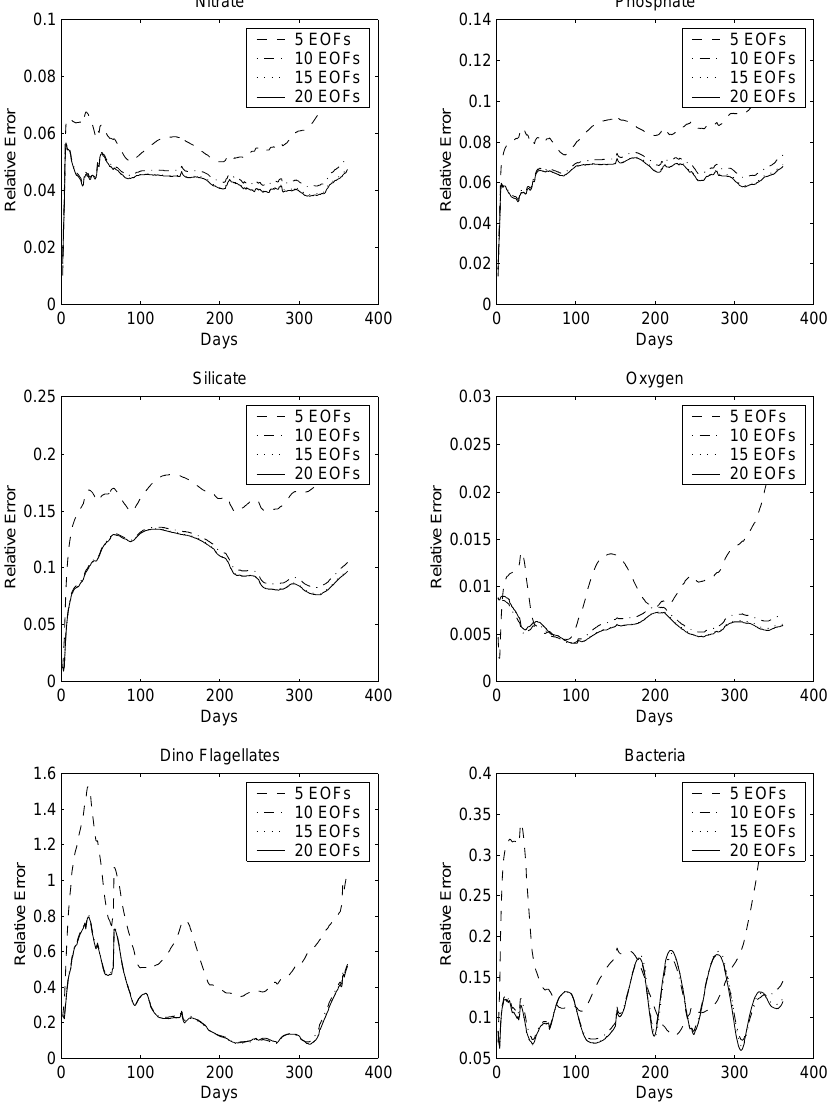
Fig. 4. Evolution in time of the relative error of the SEEK filter with 5, 10, 15 and 20 EOFs, for nitrate, phosphate, sil- icate, oxygen, dino flagellates and bac- teria from twin